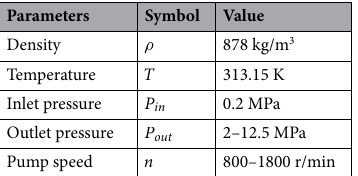
Table 3. Initial and boundary conditions of